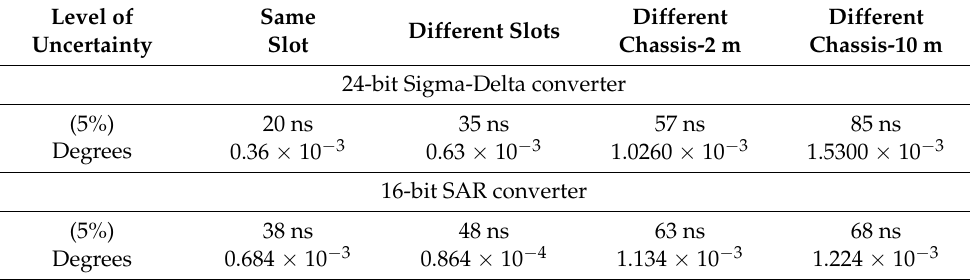
Table 5. Comparison of uncertainty levels for Sigma-Delta and SAR converters.